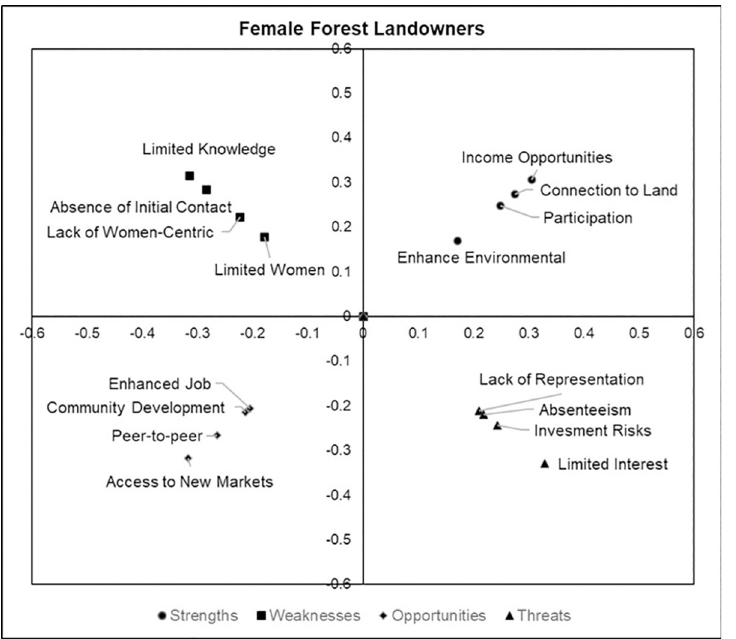
Fig 2. Perception map of factor priorities assigned by female forest landowners.